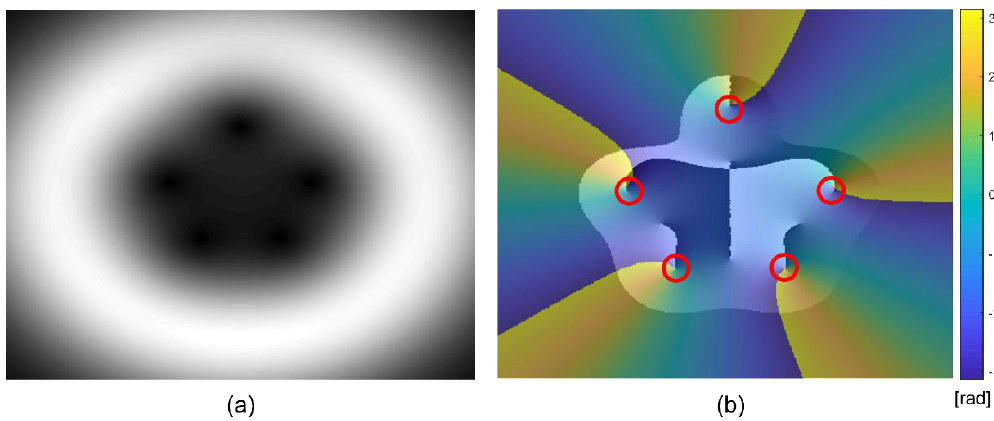
Figure 6. ( a ) Intensity of the vortex beam with a topological charge of m = 5 after separation into five vortices with topological charges of m = 1, ( b ) pseudo-phase, plotted as arg ( I con ( r , θ )) with the original phase map colored and superimposed. The red circles indicate the locations of the vortex points on both types of maps.